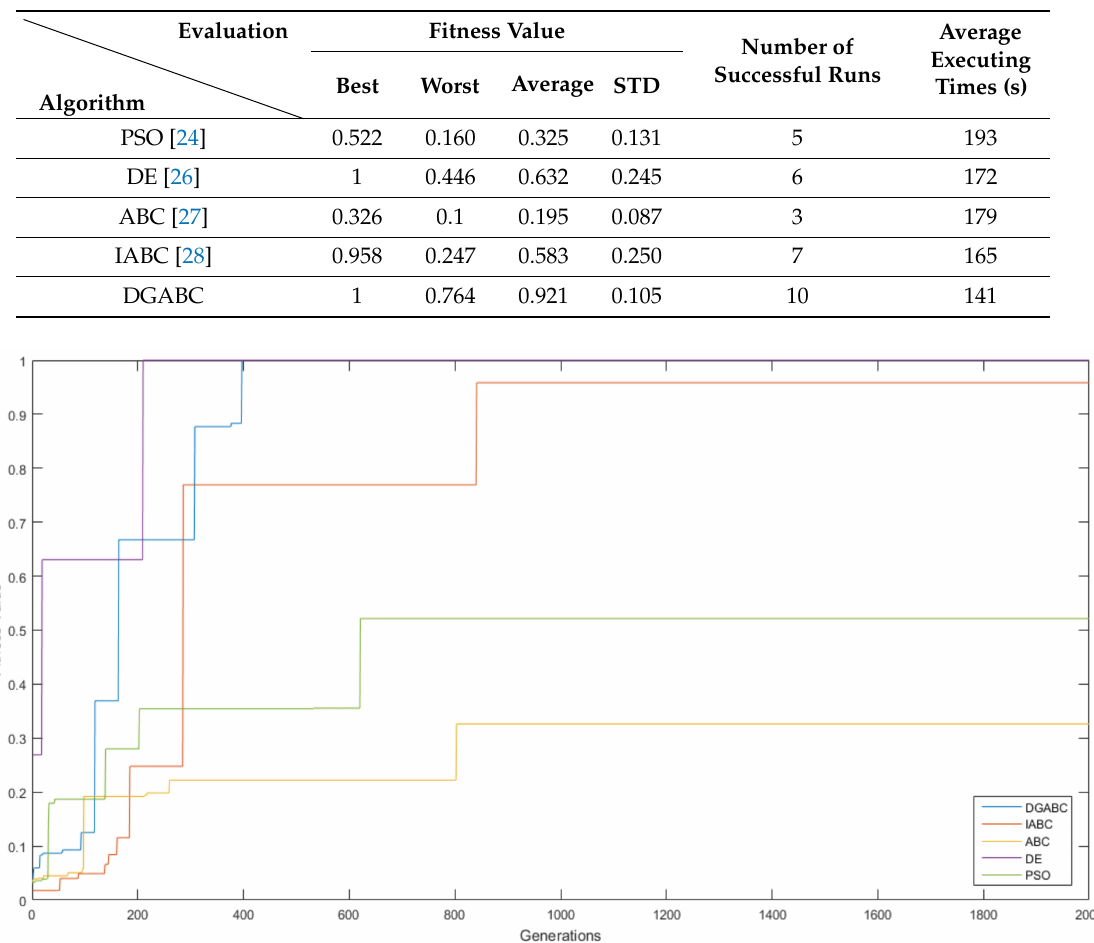
Figure 24. Learning curves of various